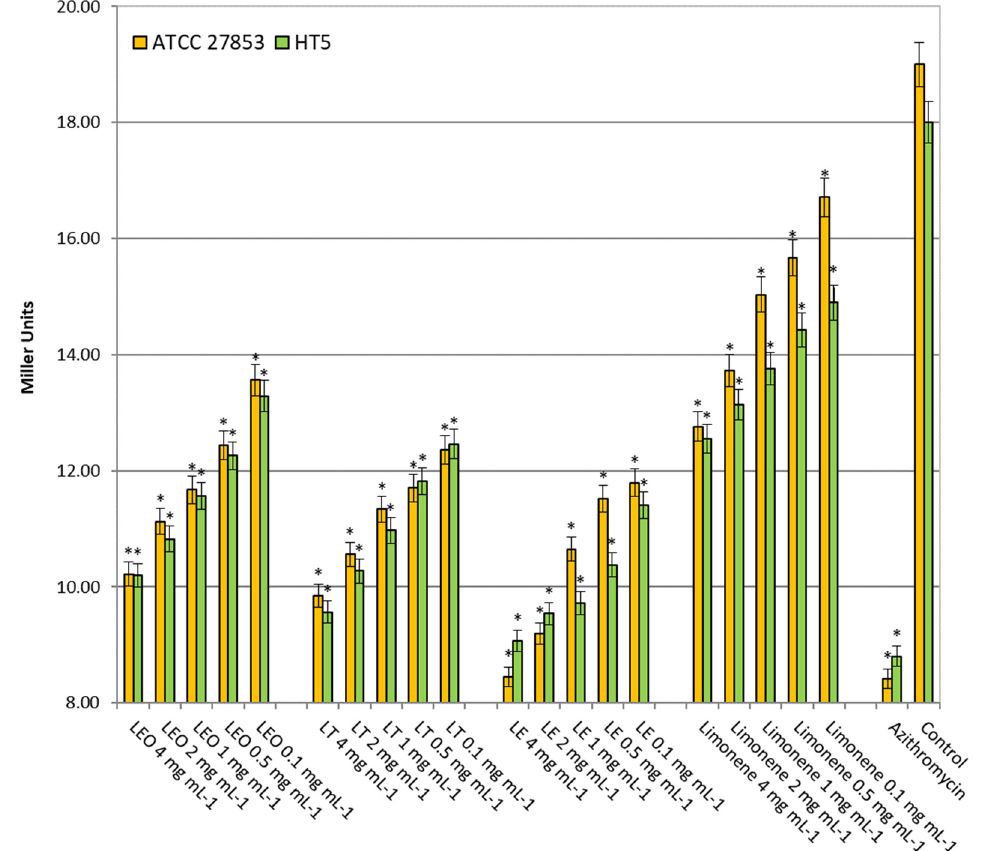
Figure 4. β -galactosidase activity of Pseudomonas aeruginosa strains without (control) and in the presence of azithromycin (5 µ g mL − 1 ) or different lemon oils concentrations (0.1–4 mg mL − 1 ). LEO: Lemon Essential Oil, LF: Lemon Terpenes, LE: Lemon Essence. Asterisk indicates significant differences compared to the respective control (Tukey’s multiple range test, p < 0.05).